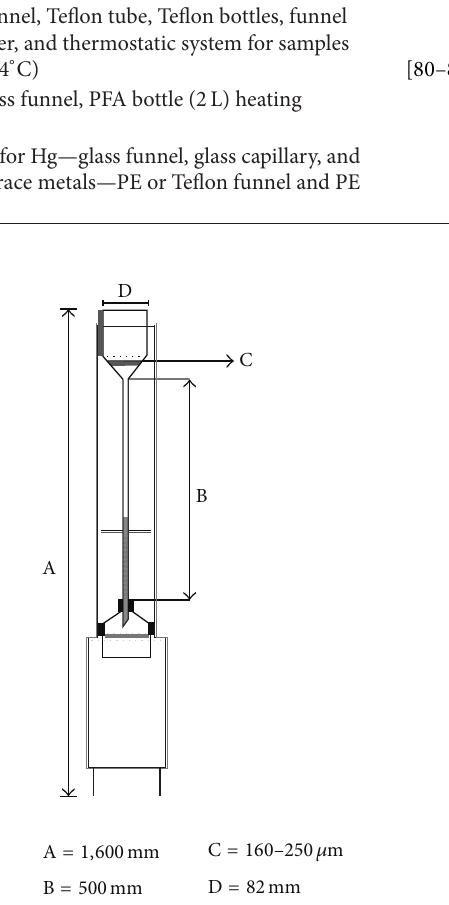
Figure 2: Scheme of a bulk type sampler for Hg